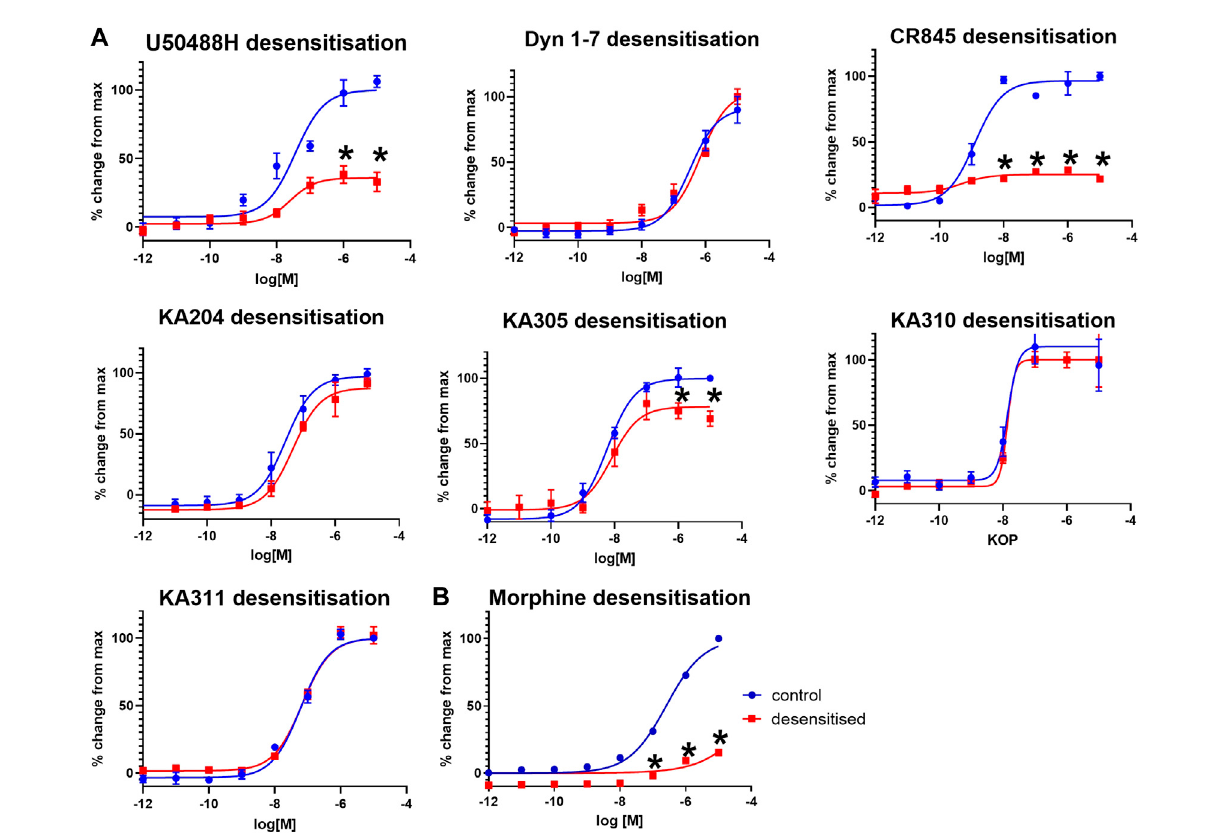
FIGURE 6 (A) KOP receptor desensitisation in cAMP assay in response to agonist peptides. (B) MOP desensitisation in cAMP assay in response to morphine. Following 6 hrs of pre-treatment with respective agonists (1 μ M), KOP (A) and MOP (B) cells were restimulated with the same peptides/compound in a concentration-response manner and cAMP production measured (red), compared to non-pre-treated cells as control (blue). Mean ± SEM n = 3 in duplicate per data point. * p < 0.0001 unpaired two-tailed t -test maximal response (%change from max) compared to